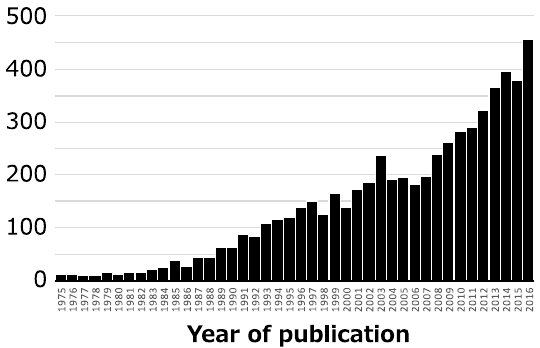
Figure 1. The number of NMR papers with the key words “drug” published between 1970 and 2016 ( Top ) and “inhibitor” between 1975 and 2016 ( Bottom ). These numbers are obtained from PubMed search (https://www.ncbi.nlm.nih.gov/pubmed).